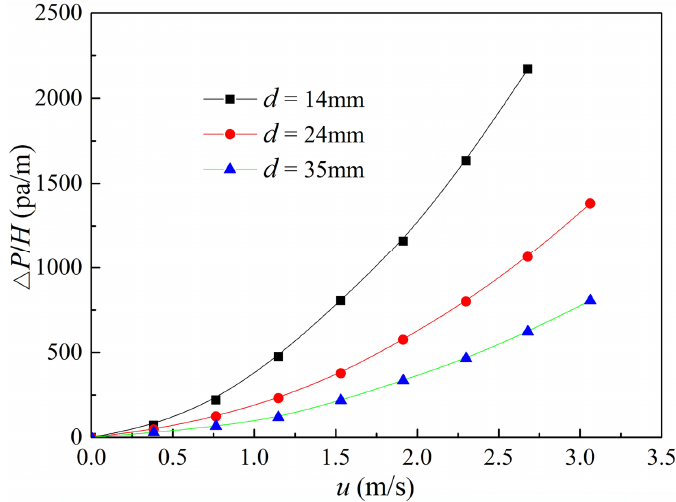
Figure 3. Changes of mean Δ P / H with u under different particle diameters.